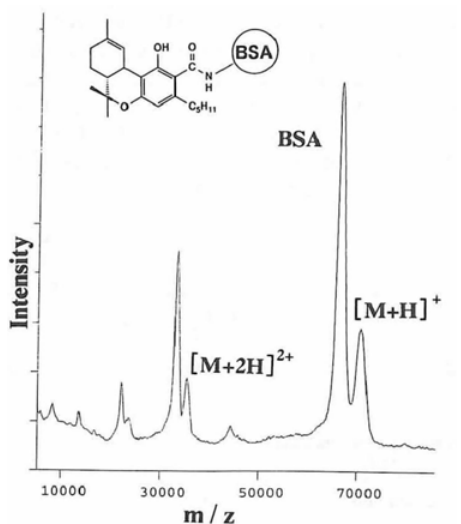
Figure 1. Matrix-assisted laser desorption/ionization tof mass spectrometry of tetrahydrocannabinolic acid-BSA